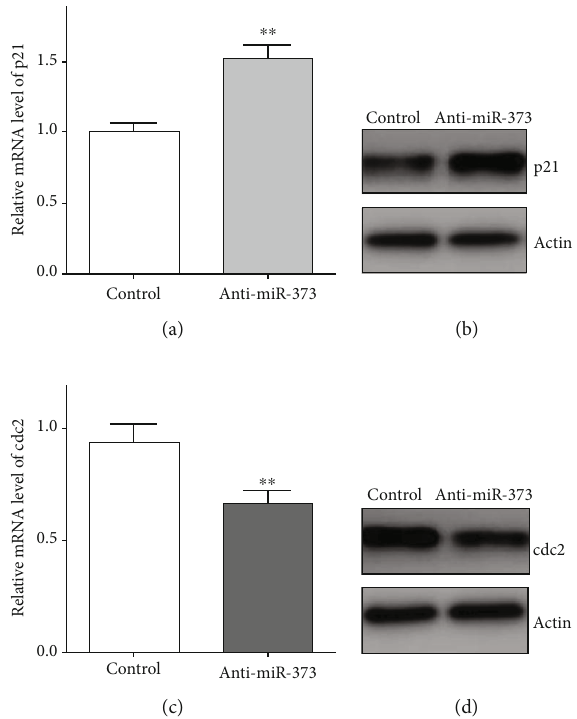
Figure 4: E ff ects of anti-miR-373 on p21 and cdc2 expression. (a) p21 mRNA level was increased in the presence of anti-miR-373 transfection by the real-time quantitative PCR, and (b) western blot result also proved that higher p21 expression was obtained after anti-miR-373 transfection; (c) cdc2 mRNA level was decreased in the presence of anti-miR-373 transfection by the real- time quantitative PCR, and (d) western blot result also proved that lower cdc2 expression was obtained after anti-miR-373 transfection (bars indicate the standard deviation of the mean; each experiment was performed in triplicate; ∗∗ p < 0 : 01